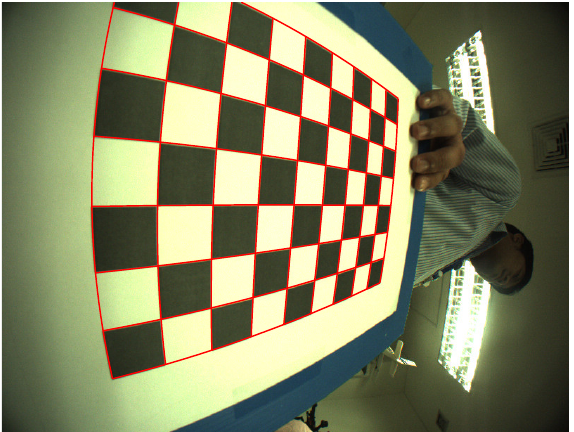
Figure 10: The re-projections of the lines on calibration plane onto the image from Ladybug 3 camera. The re-projected lines are drawn with red